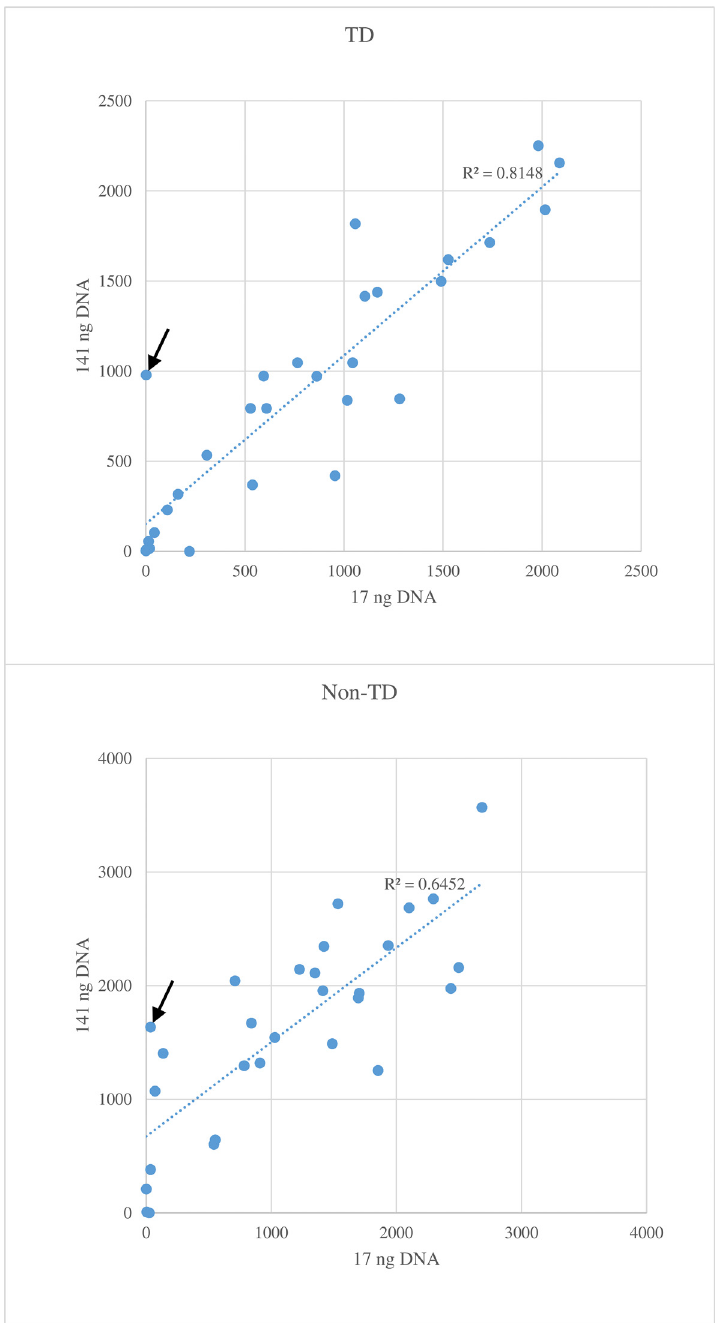
Fig 3. Average number of sequence reads per marker using 17 ng (x-axis) and 141 ng DNA (y-axis) as template. The top figure used touch down (TD) and the bottom figure used non-TD PCR. The arrow points to the number of reads of CNL9 marker for Sr35